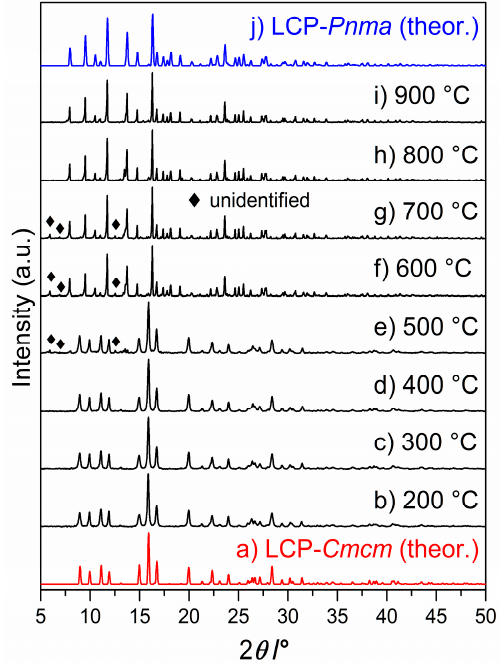
Figure 5. Ex situ X-ray powder diffraction patterns of LCP- Cmcm (PO) samples after heat treatment for 6 h in air in the temperature range from 200 to 900 °C (increment: 100 °C, b – i ), in comparison with the theoretical patterns of LCP- Cmcm ( a , red ) and LCP- Pnma ( j , blue ). The quantitative transition from phase-pure LCP- Cmcm ( h ) to the olivine-type LCP- Pnma ( a ) can be observed upon heating. The reflections arising from an unidentified secondary phase are marked with the symbol ♦ .